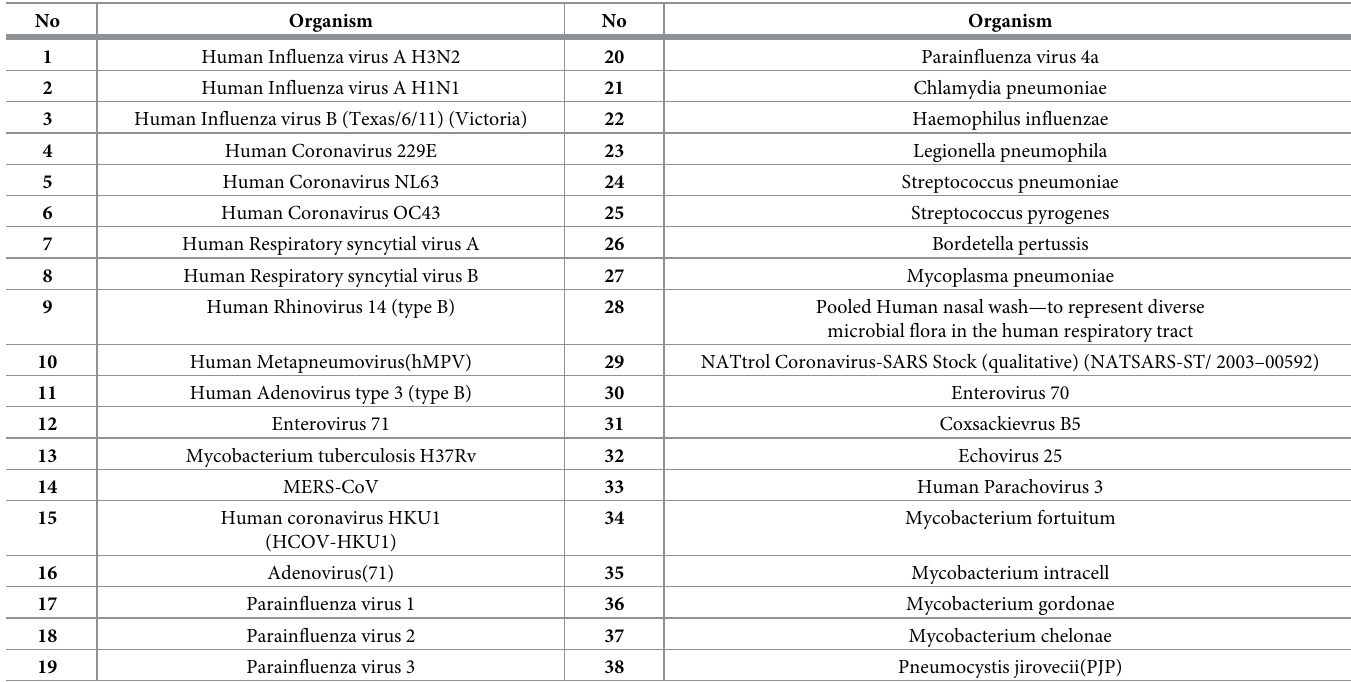
Table 3. List of pathogens tested for cross-reactivity.